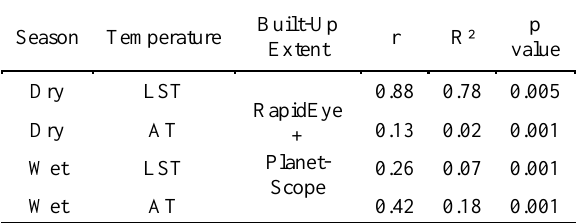
Figure 7. Mean Annual LST and AT of Baguio City from 1990 to 2018. Increasing LST was observed during the study period.